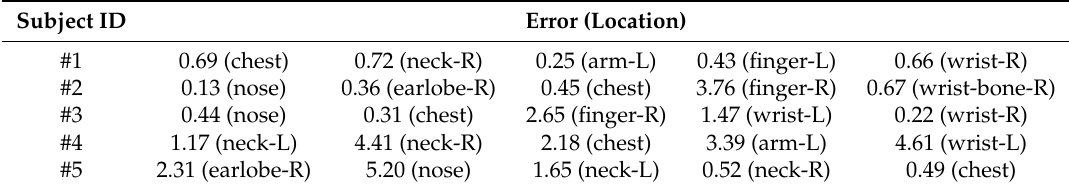
Table 1. The MAE of estimated IRRs versus reference data from thermocouple using our proposed algorithm in top five selected locations with lowest errors in the first dataset (Figure